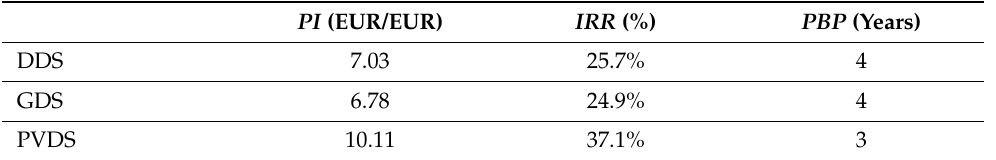
Table 5. Profitability index ( PI ), internal rate of return ( IRR ), and payback period ( PBP ) of the economic investment required for installing a diesel-powered drying system (DDS), a grid-powered drying system (GDS), and a PV-powered drying system